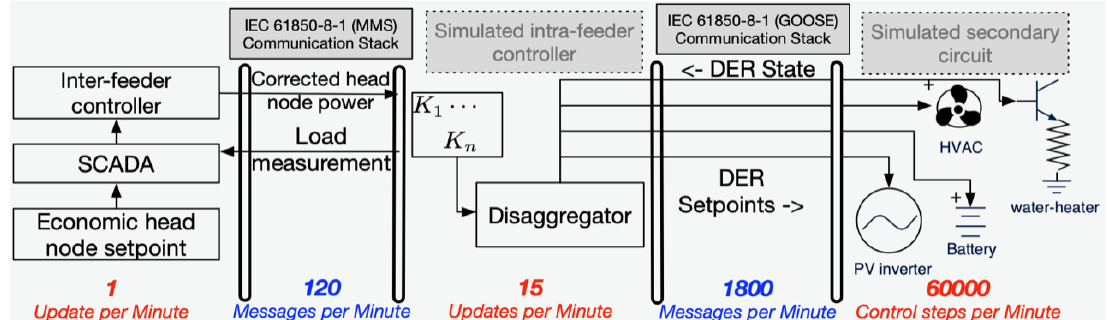
Figure 12. A schematic diagram showing the interacting elements in the validation environment. Here a single feeder and service transformer unit are considered. A total of 60 DER assets are coordinated by the system using International Electrotechnical Commission (IEC) 61850 compliant information models and communication